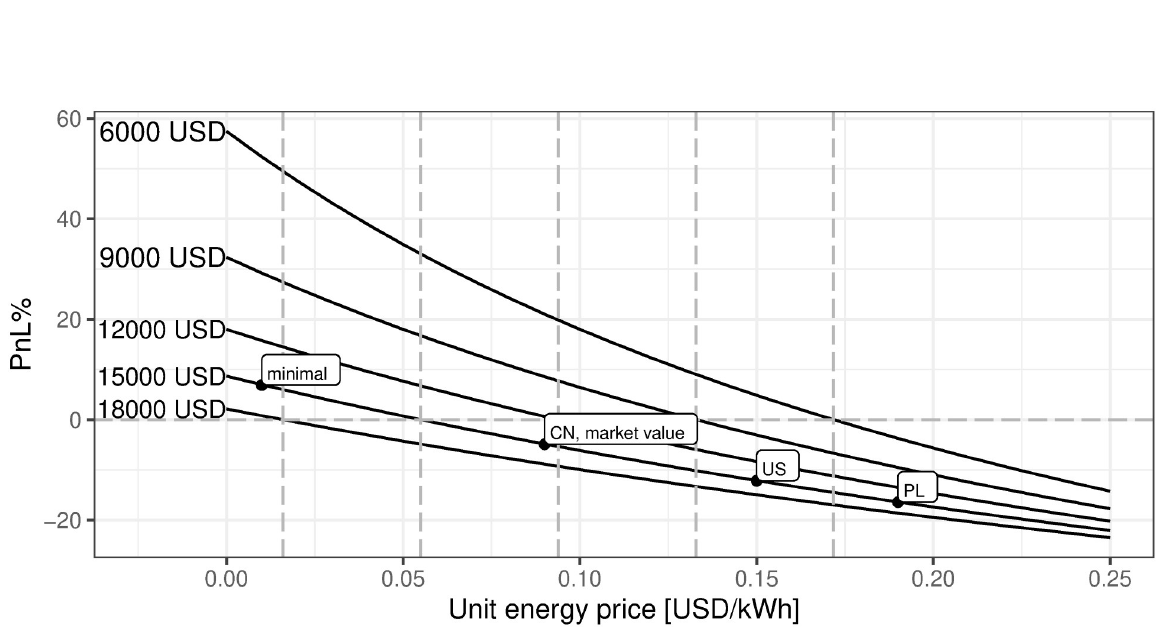
Fig 30. BTC mining profitability (PnL%) for different levels of unit energy prices and different levels of hardware cost. Note: PnL%, calculated according to the formula 6. Hypothetical unit energy price ranges from 0 up to 0.25 USD per kWh hardware cost per unit ranges from 6000 USD up to 18000 USD. Antminer S19J Pro is assumed as the most optimal mining machine. Minimal, CN, PL, and US define respectively minimal world energy price level, China, Poland, and US located mining profitability corresponding to the local energy price, provided that remaining parameters are equal. The market value point describes the current state of market mining efficiency assuming parameters outlined in the section Values of variables as of 2021/12/03. Source: own calculations based on data described in section Crucial assumptions and data.